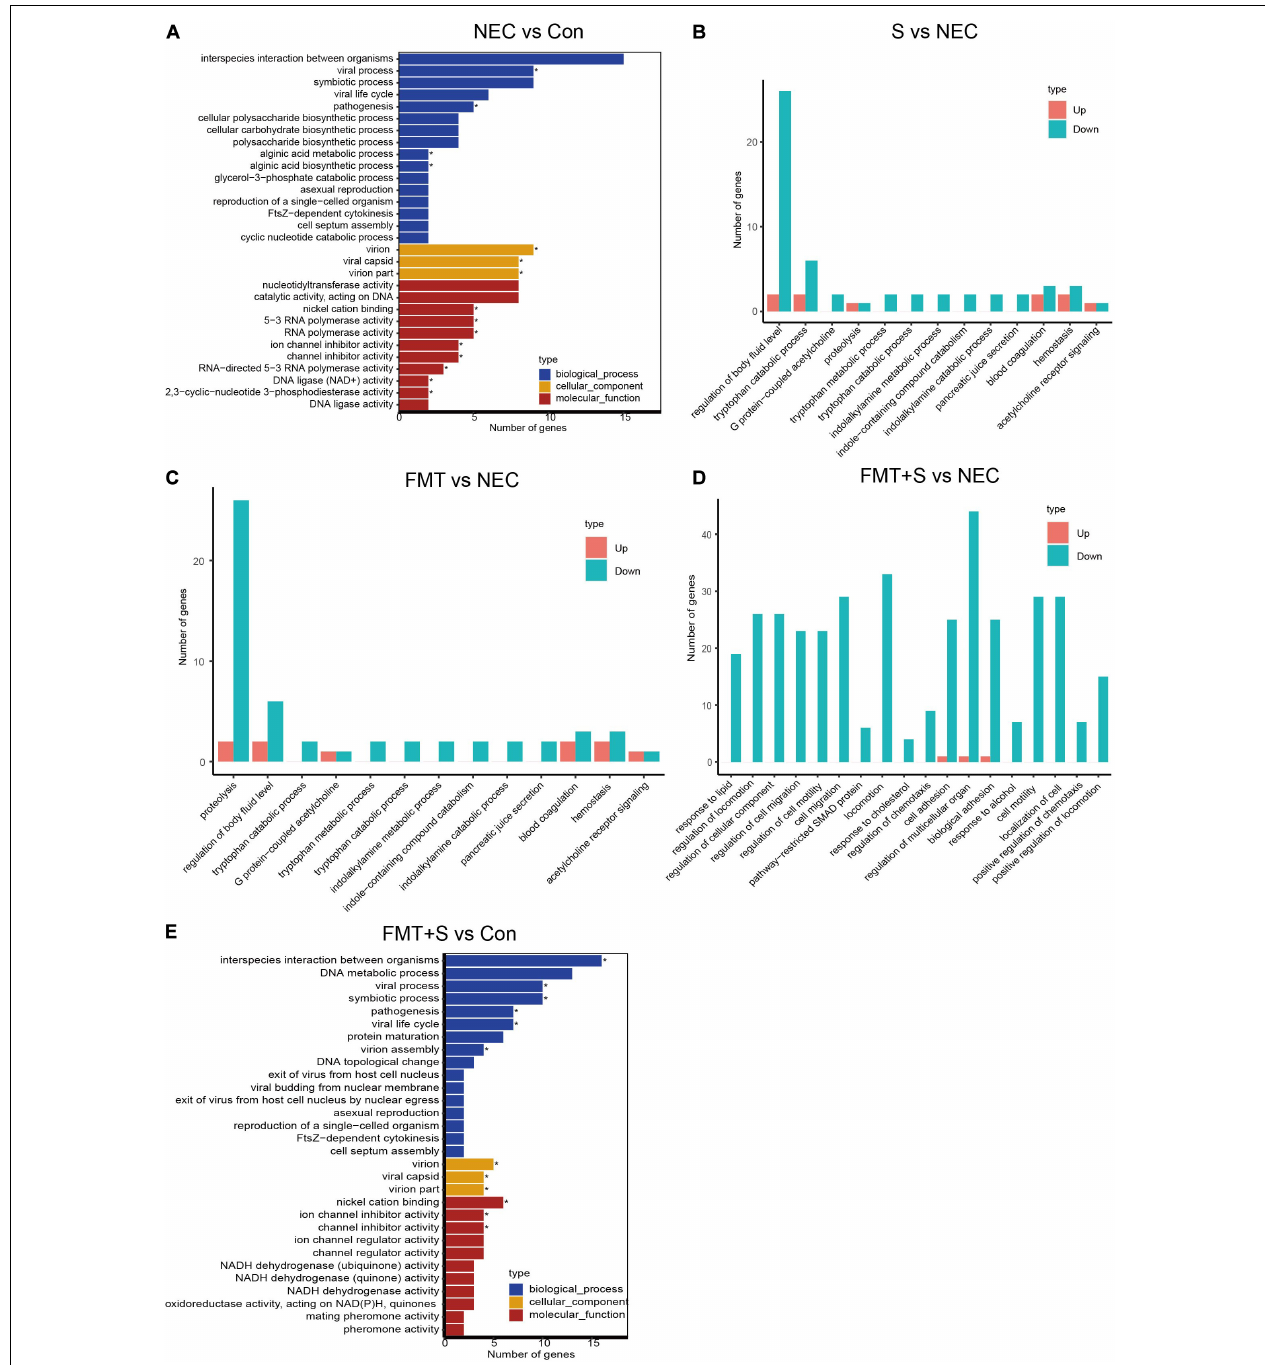
FIGURE 4 | The transcriptome shared a similarity to the healthy group after FMT and sulperazone combination treatment. (A) GO enrichment for NEC vs. control. (B) GO enrichment for sulperazone vs. NEC. (C) GO enrichment for fecal microbiota transplantation vs. NEC. (D) GO enrichment for sulperazone plus fecal microbiota transplantation vs. NEC. (E) GO enrichment for sulperazone plus fecal microbiota transplantation vs. control. Con, control; NEC, necrotizing enterocolitis; S, Sulperazone; FMT, fecal microbiota transplantation; GO, gene ontology. *Represents for the statistic difference (*, p <